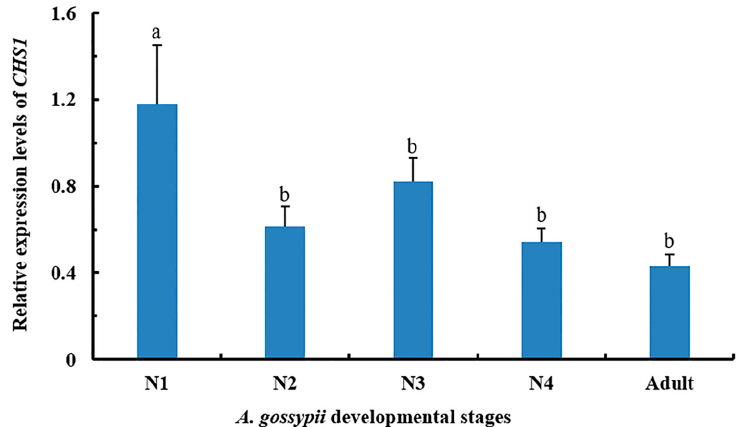
Figure 1. Relative expression pattern of CHS1 gene at different developmental stages of A. gossypii analyzed by qRT-PCR. The expression level is expressed as the mean (±SE) of the three biological replicates, and thirty insects were used per pooled RNA sample. Letters above the bars represent significant differences at p < 0.05 level (one-way ANOVA followed by Tukey’s HSD test). EF1 α and β -actin are used as the internal control. N1: first instar; N2: second instar; N3: third instar; N4: fourth instar.